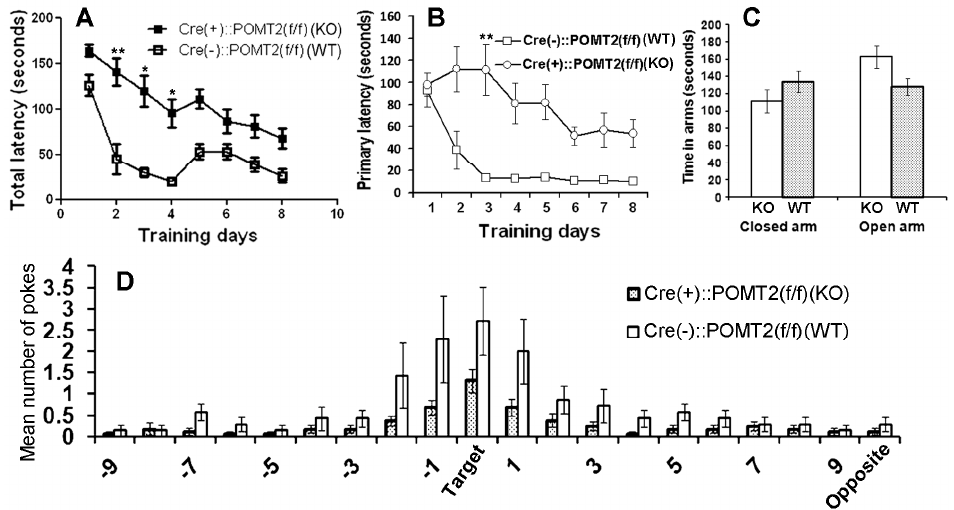
Figure 1. Cerebral cortex ‐ specific protein O ‐ mannosyltransferase 2 (POMT2) knockout mice [Emx1